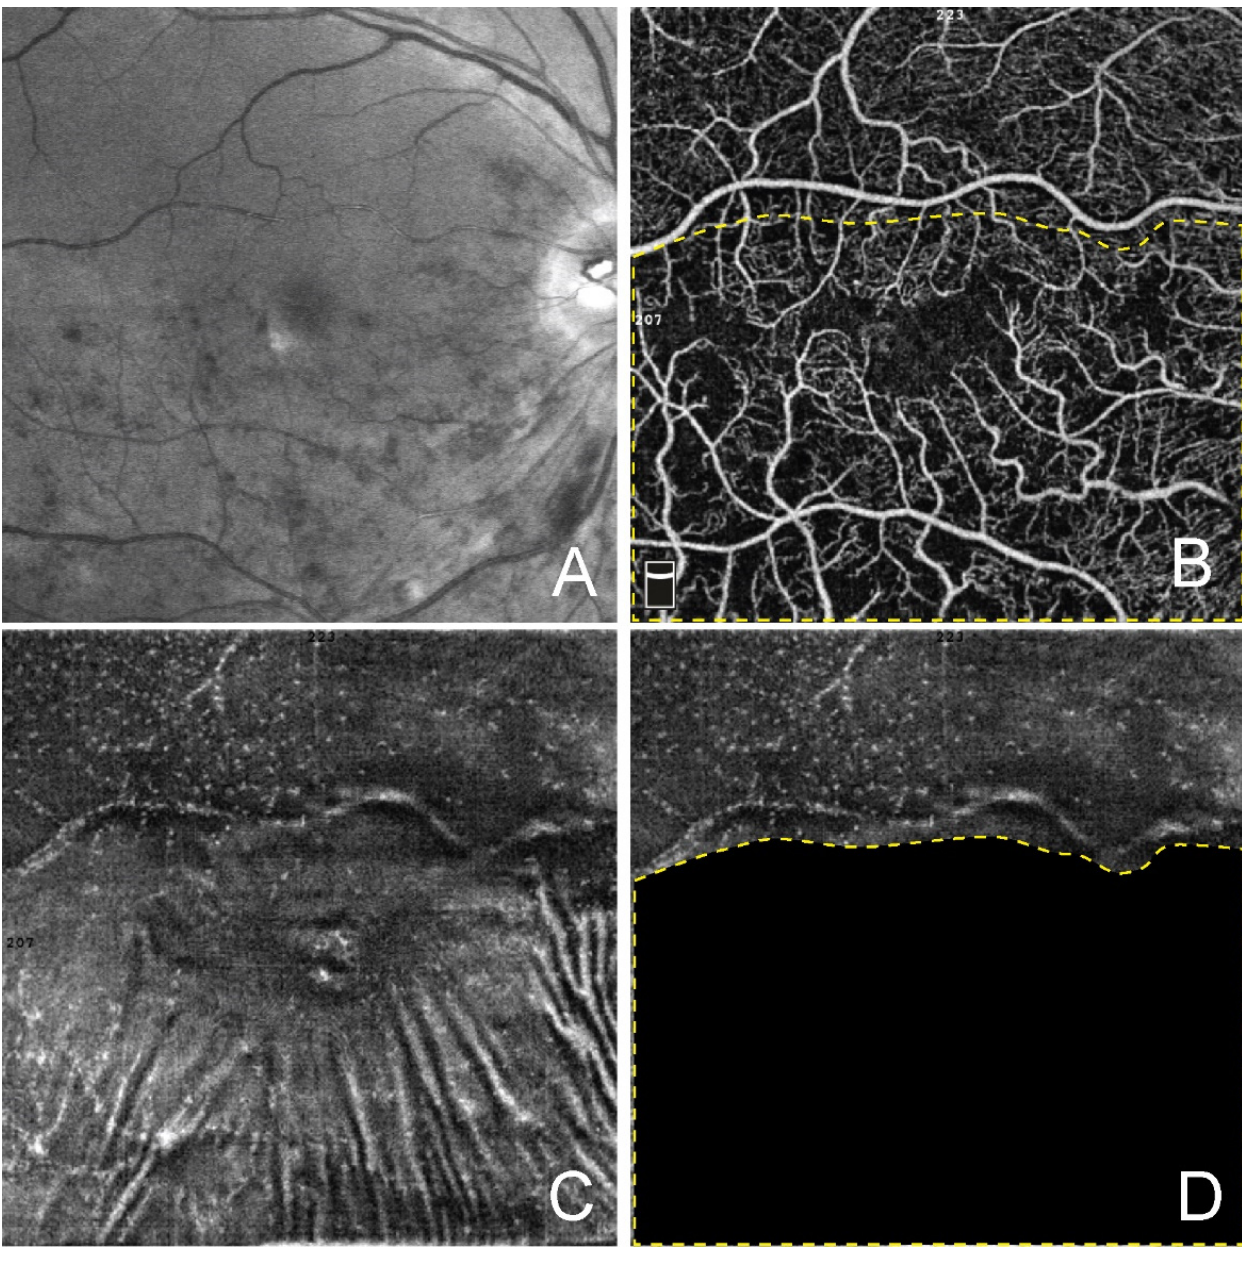
Figure 2. Counting of retinal macrophage-like cells in branch retinal vein occlusions. ( A ) Green scanning laser ophthalmoscopy showing area of occlusion. ( B ) En face optical coherence tomography angiography (OCTA) projection in the eye with branch retinal vein occlusion (BRVO). The yellow dashed line delineates the area of BRVO. ( C ) Structural en face OCTA projection displaying MLC. ( D ) Structural en face OCTA projection with the area affected by RVO masked to calculate MLC in unaffected area. The yellow dashed line delineates the area of BRVO.